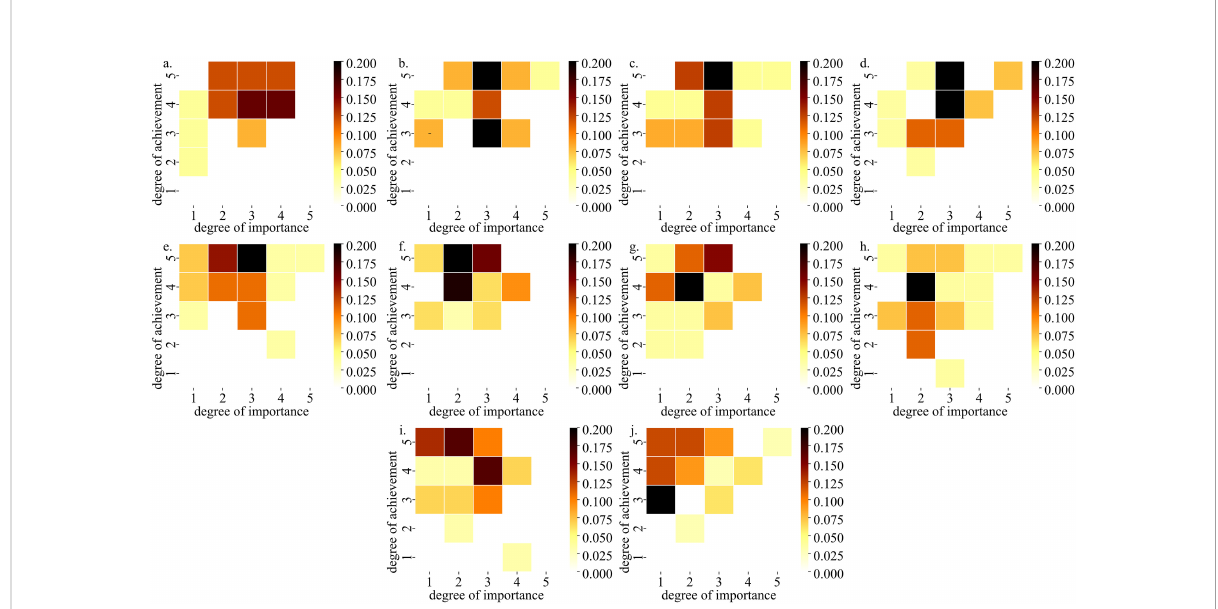
FIGURE 6 Distributions of the combinations of degrees of importance and achievement for each question ( A – J , corresponding to Table 3) regarding freshwater